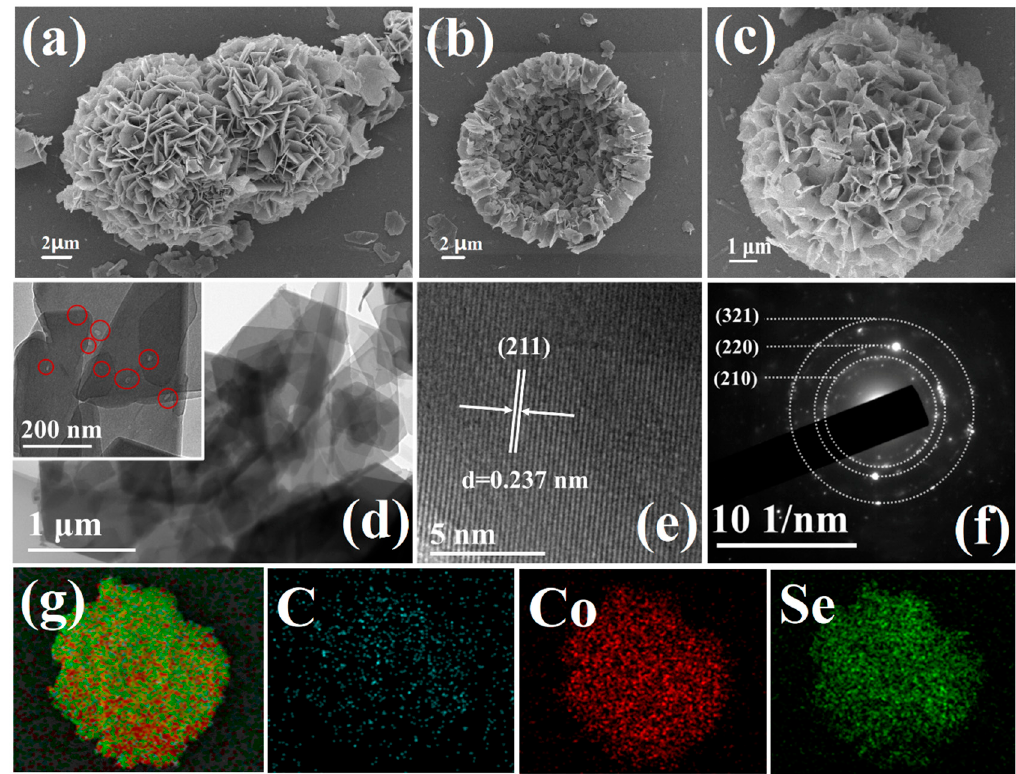
Figure 2. ( a , b ) SEM of Co ‐ PHF. ( c ) SEM of CoSe 2 ‐ PHF, and ( d ) TEM of CoSe 2 ‐ PHF. ( e ) HR ‐ TEM images of CoSe 2 ‐ PHF. ( f ) SAED pattern of CoSe 2 ‐ PHF. ( g ) Element mapping images for C, Co, and Se elements in CoSe 2 ‐ PHF.